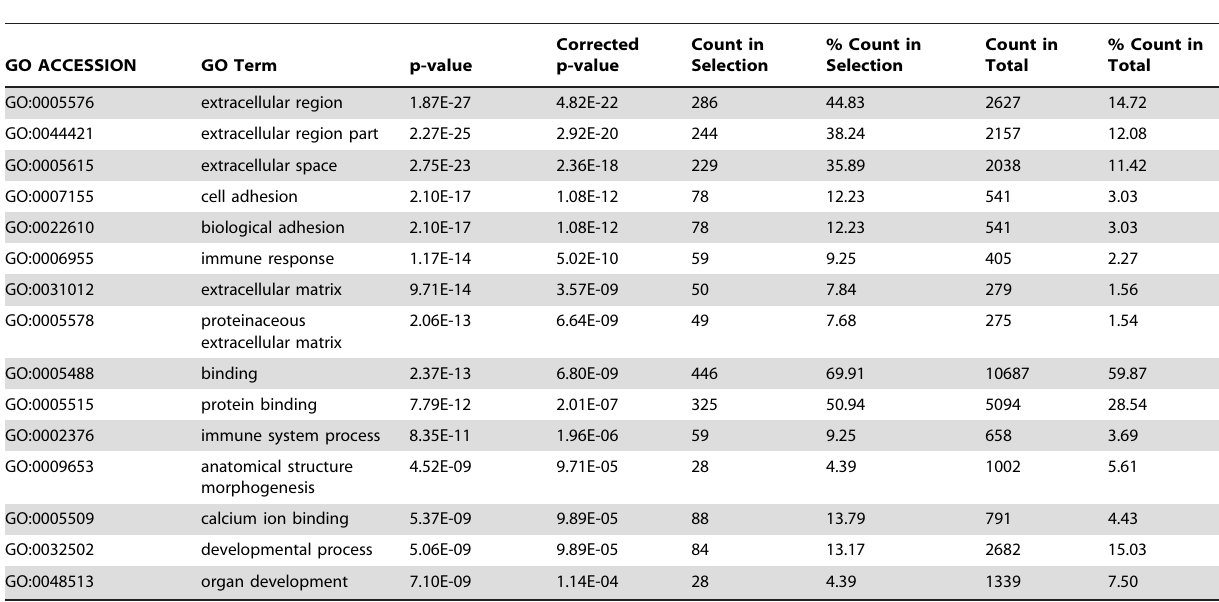
Figure 4. Gene Ontology (GO) analysis of was performed using Gene Spring GX 10.0.2 (Agilent technologies Inc and Strand Life Sciences Pvt Ltd). With the gene set comparisons that were described in the figure 3A GO analysis was performed. Pie chart A shows the statistically significant (P , 0.1) differentially regulated genes between wild type and Mta1- KO samples matching with three broad GO terms (Cellular components, Biological process and Molecular Function), Pie chart B ( Mta1- KO and Mta1 -KO/ Mta1 ) shows the GO terms matching with the differentially regulated genes in this comparison. Pie chart C and pie chart D show the same for bona fide Mta1 regulated genes in the presence of P53 (126) and P53 -KO vs. P53 - KO/ Mta1 (genes regulated by Mta1 in the absence of P53 , 266 ) respectively. doi:10.1371/journal.pone.0017135.g004 Table 5. GO Analysis of the genes differentially regulated between the WT & Mta1 -KO with $ 2.0 fold